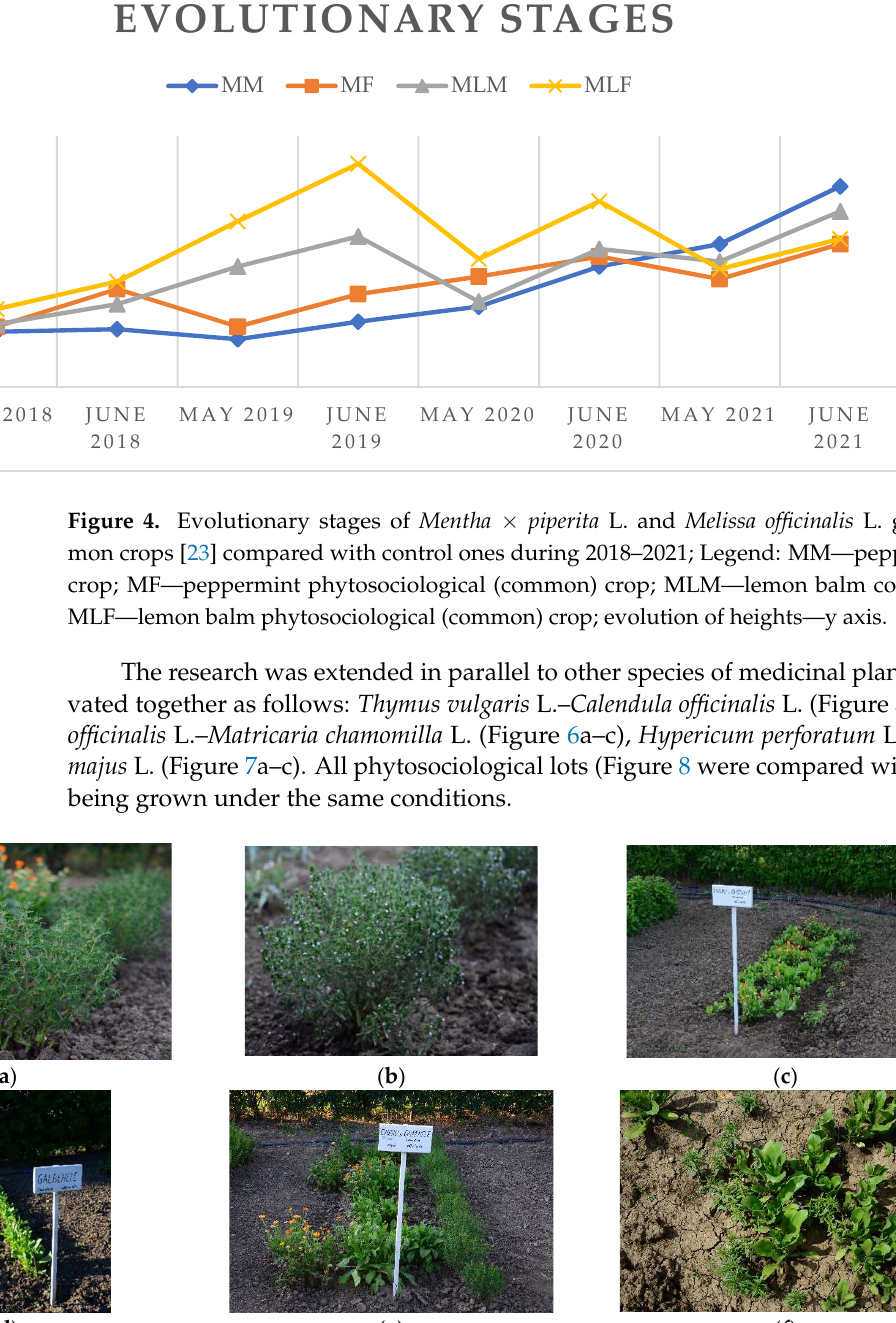
( e ). Phytosociological crop thyme (h-30 cm) and marigolds (h-41 cm),